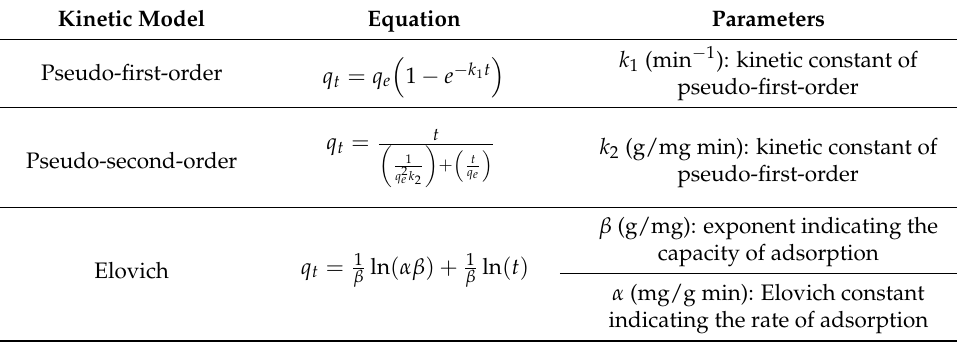
Table 2. Kinetic models evaluated in this